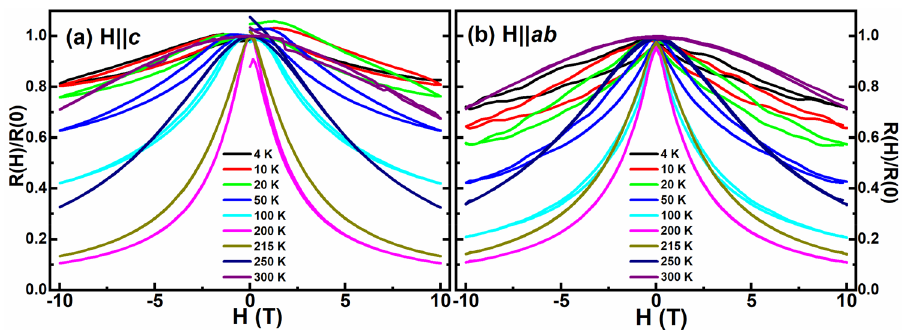
Figure 10. Isothermal evolution of the resistance as a function of the applied magnetic field obtained for the ultra-thin heterostructure in ( a ) H||c and ( b ) H||ab configurations.